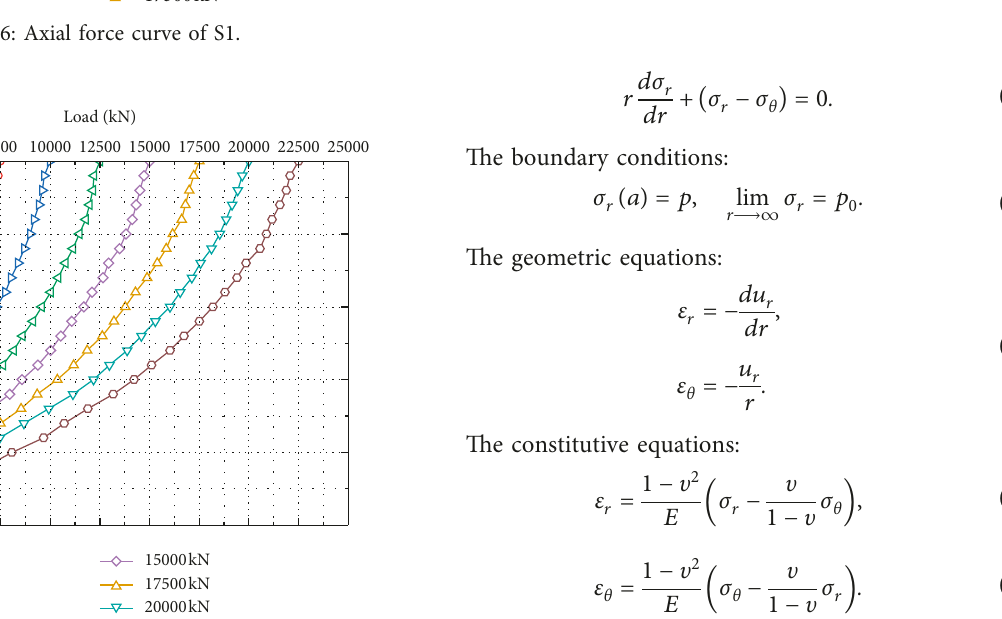
Figure 8: Curve of pile lateral friction increases proportion along pile